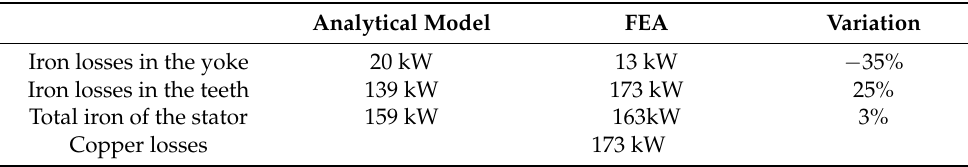
Figure 12. Evolution of the temperature in the winding at the maximal power. Table 7. Losses of the optimal generator at the maximal power (10 MW, 1.03